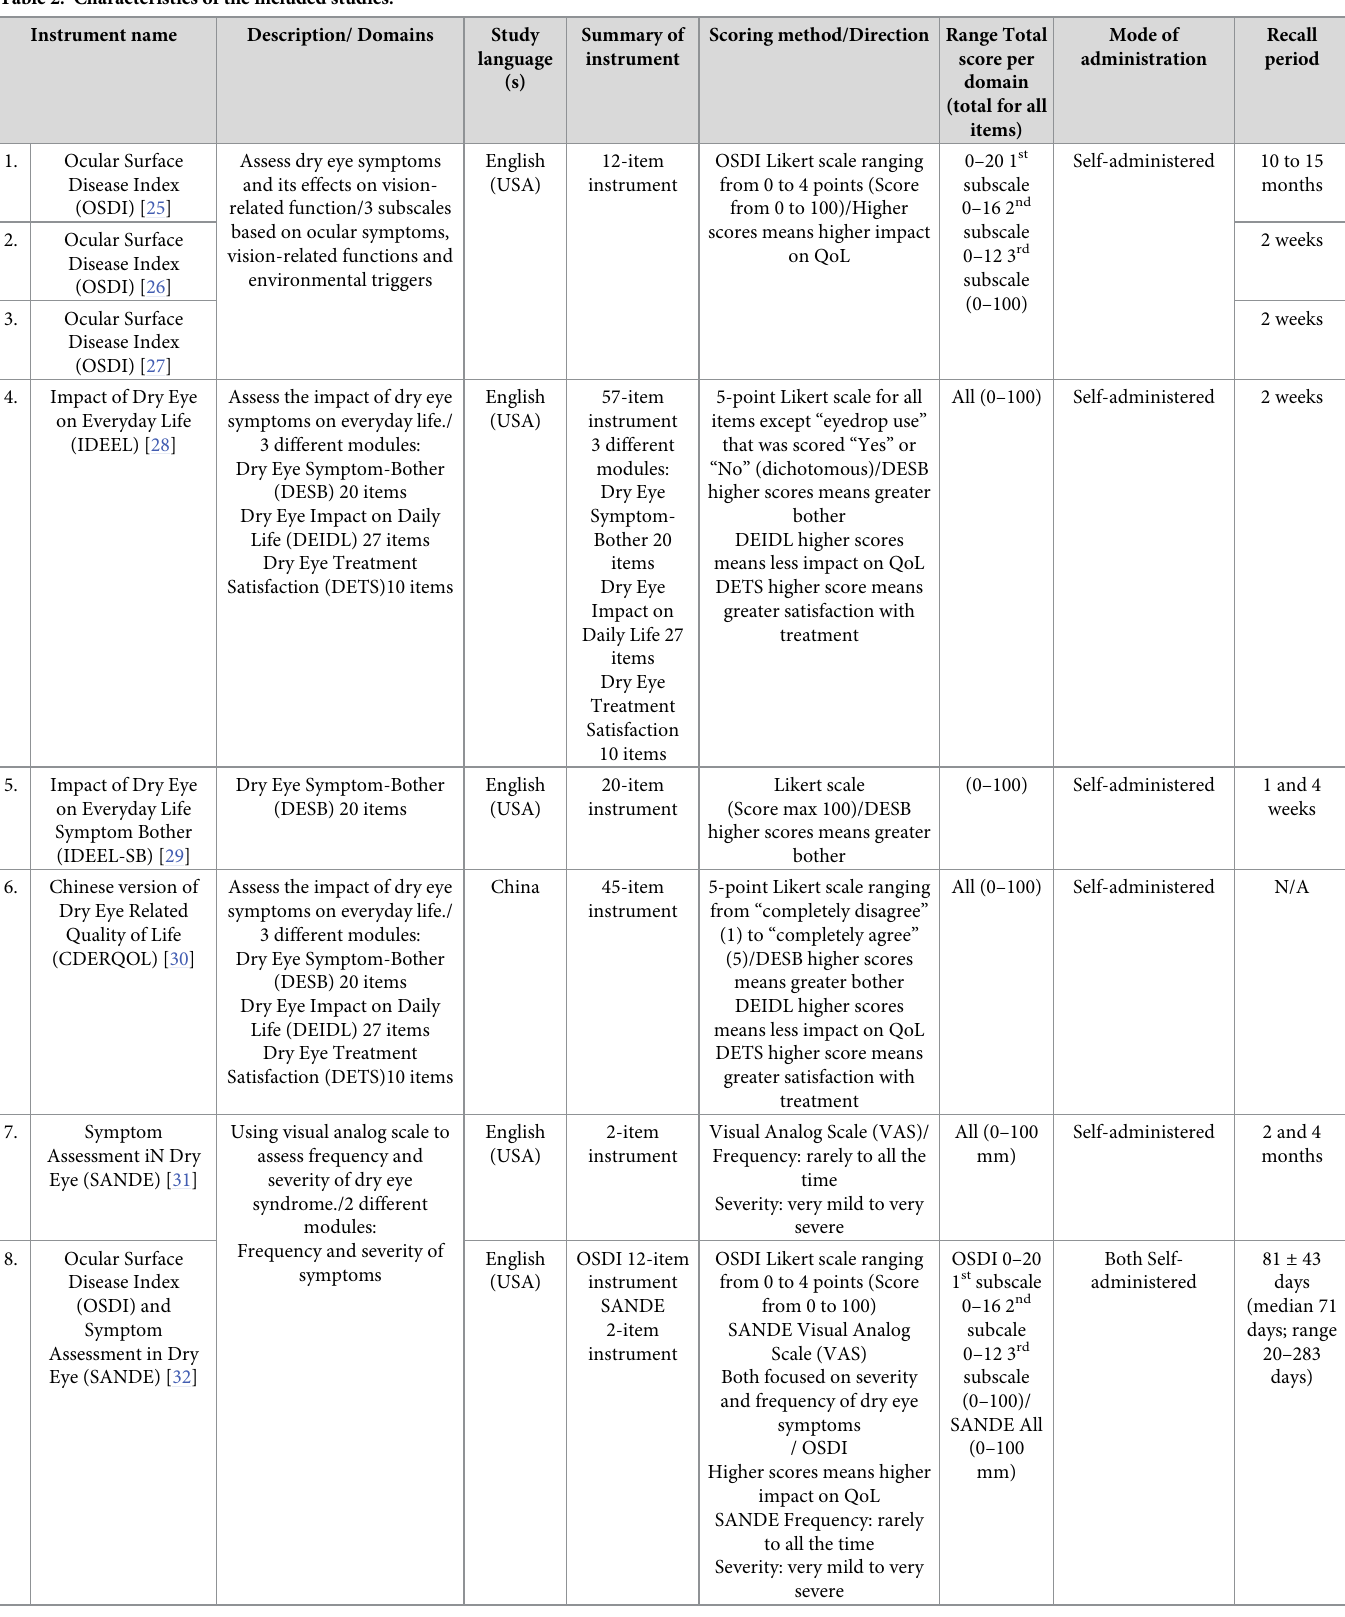
Table 2. Characteristics of the included